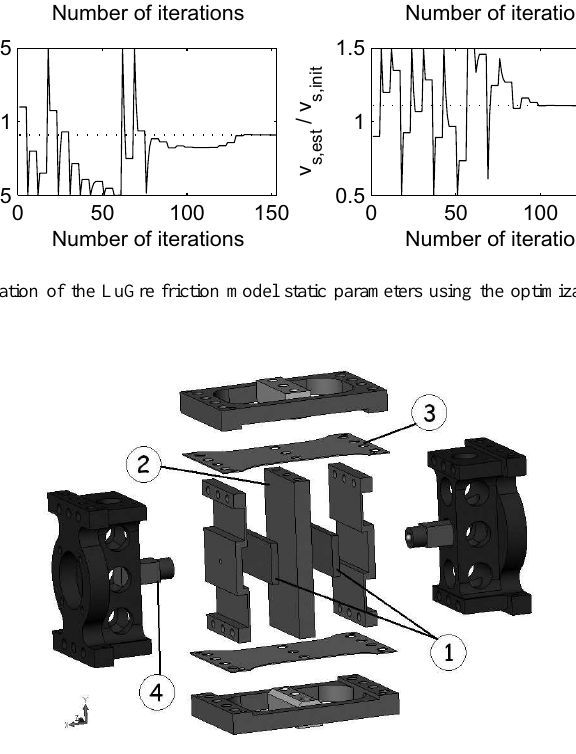
Fig. 5. CAD model of the friction